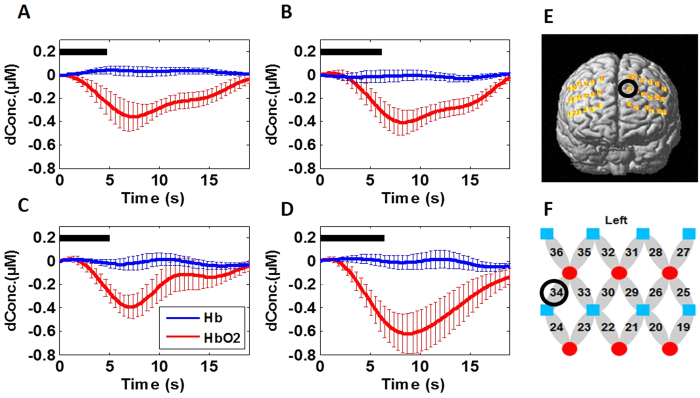
Mean Stroop-evoked hemodynamic changes of HbO2 in left DLPFC (i.e., channel 34 shown in Panels (E,F)) from both groups. (A,B) Group-averaged HbO2 response from the healthy group evoked by Stroop1 and Stroop2 tasks, respectively. (C,D) Group-averaged HbO2 response from the subjects with PTSD evoked by Stroop1 and Stroop2, respectively. In all four panels, the thick black bars represent the stimulation periods; the red lines represent the mean time courses of HbO2; the blue lines represent the mean time courses of Hb; the error bars represent the standard errors of mean. (E) It shows the position or location of channel 34 on a standard human brain template. (F) It shows the configuration of fNIRS channels on the left frontal cortex. Red circles represent light sources, blue squares represent detectors, and gray ellipses represent the nearest source-detector pairs (as channels) to measure the brain activities.